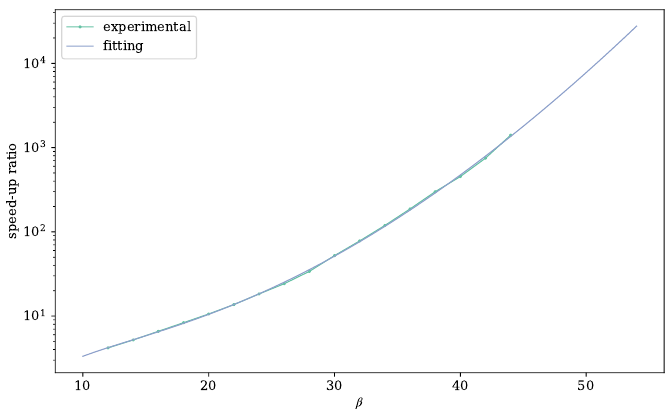
Figure 7. Speedup ratio of extreme pruning.